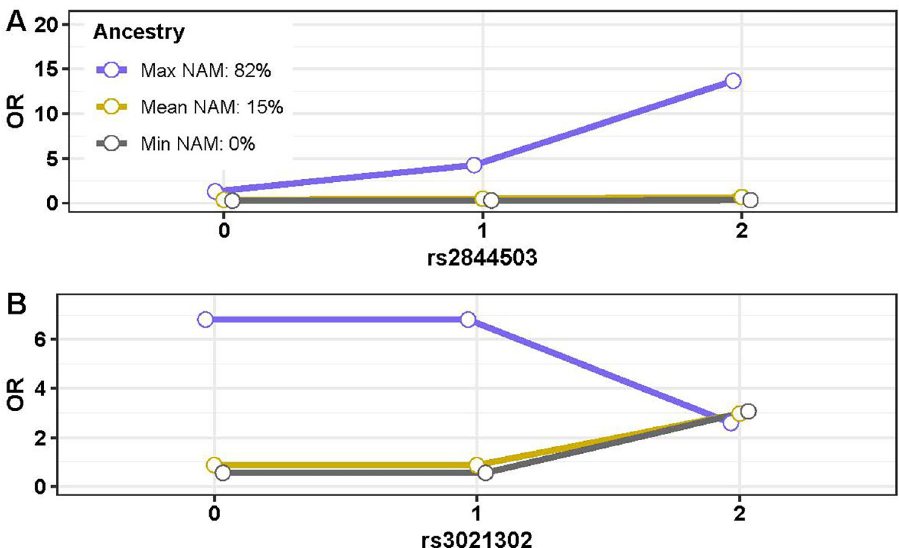
Fig 4. Global ancestry risk modification in Hispanics. Expected odds ratios (OR) are depicted on the Y axis for individuals with 0, 1, or 2 copies of the variant allele for each SNP, under varying levels of NAM ancestry. A. rs2844503 demonstrates a risk effect in individuals with the maximum observed NAM while no effect is seen for individuals with the minimum or mean observed NAM. B. rs3021302 demonstrates a protective effect in individuals with the maximum observed NAM while a risk effect is seen in individuals with the minimum or mean observed